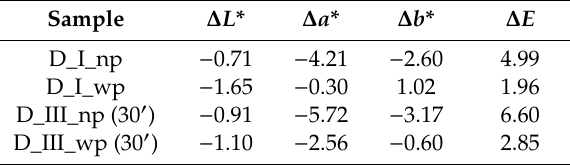
Figure 12. Optical images at 10 × magnification of mock-up D treated with propylene carbonate solvent ( a , c ) and Nanorestore Gel ® gel for 30 min ( b , d ) on the unprotected and protected area. ( a ) D_I_np; Table 5. Colorimetric measurements on unprotected and protected areas, respectively after application of propylene carbonate and of Nanorestore Gel ® (for 30